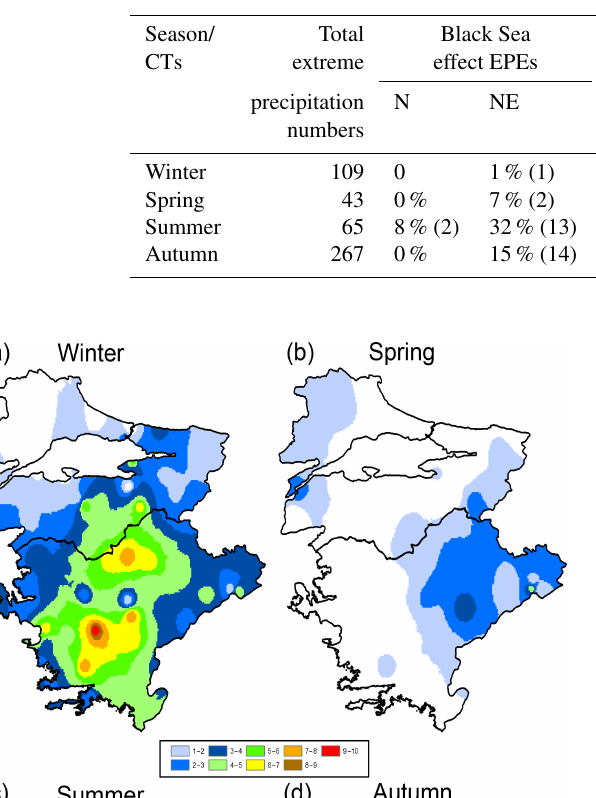
Table 1. Total extreme precipitation numbers over Marmara considering 51 stations and their percentage frequency distribution according to Black Sea effect, cyclonic, and convective precipitation types for the period 2006–2015. The total number of the days with EPEs are shown in parentheses.